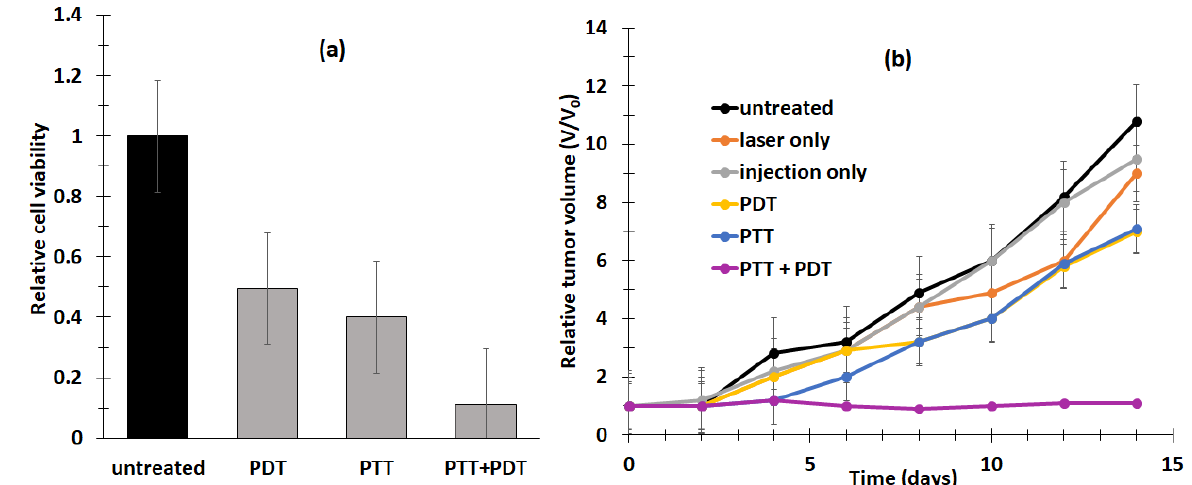
Figure 3. ( a ) In vitro cytotoxicity effect of UCNP@BSA-RB&IR825 for PDT, PTT and combined PTT– PDT treatment. PDT (808 nm, 0.5 W/cm 2 ) and PTT (980 nm, 0.4 W/cm 2 ). ( b ) In vivo tumor growth in different groups of mice after various treatments, as indicated: 1: untreated; 2: laser only (808 nm and 980 nm); 3: injection only; 4: PDT; 5: PTT, 6: PTT + PDT. Wavelengths of 808 nm (0.5 W/cm 2 , 5 min) and 980 nm (0.4 W/cm 2 , 30 min) were used to separately trigger PTT and PDT, respectively. Adapted from Chen et al. [21] .